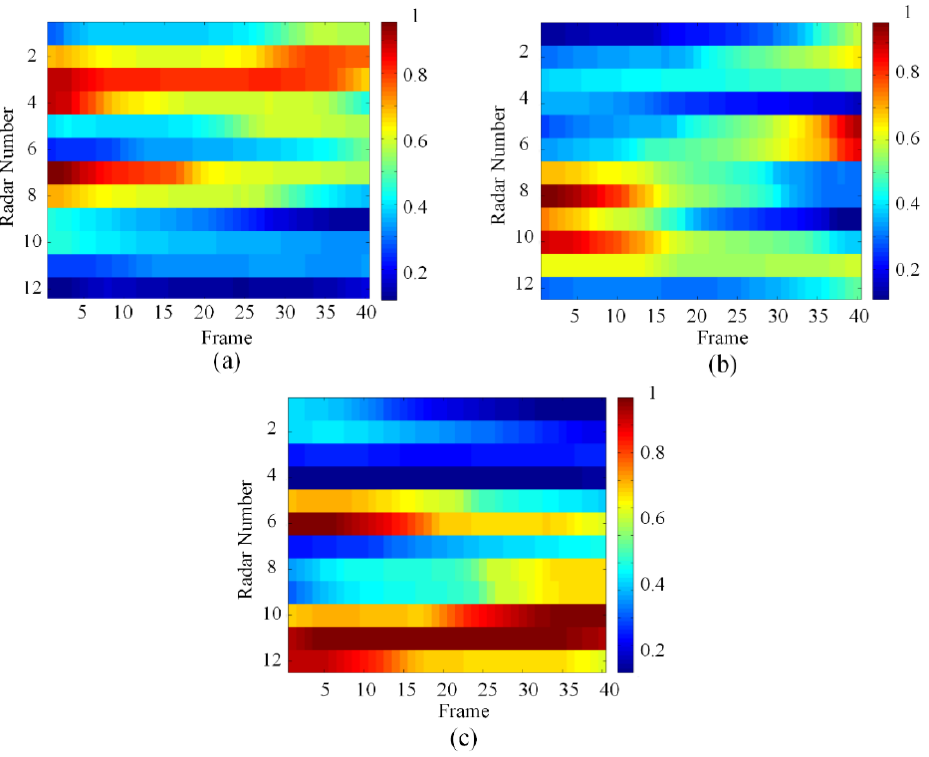
Figure 7. The priorities of each target: ( a ) target 1, ( b ) target 2, and ( c ) target 3.